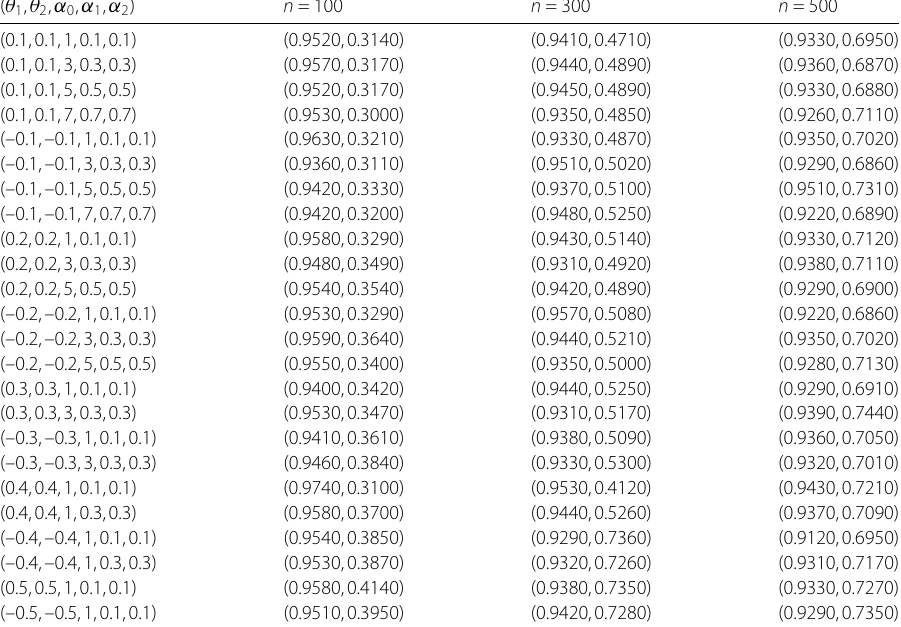
Table 1 The simulation results for sequence I ( θ 1 , θ 2 , α 0 , α 1 , α 2 ) n = 100 n = 300 (0.1,0.1,1,0.1,0.1)